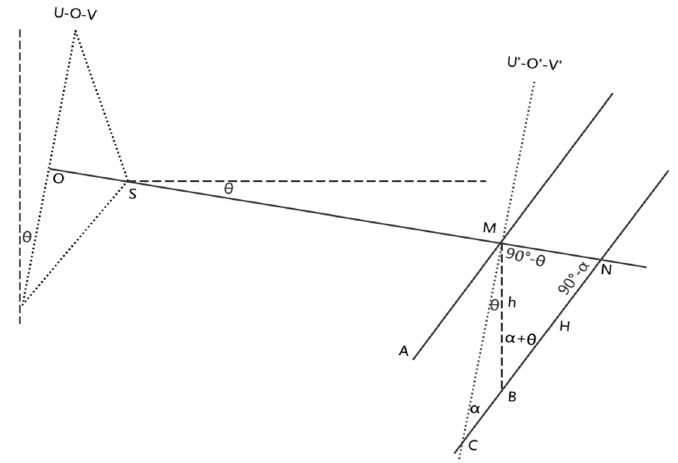
Figure 7. The central projection when the photographic baseline is non-level and the barcode is not vertical. The geometrical relationship of relevant parameters before and after settlement is also shown.